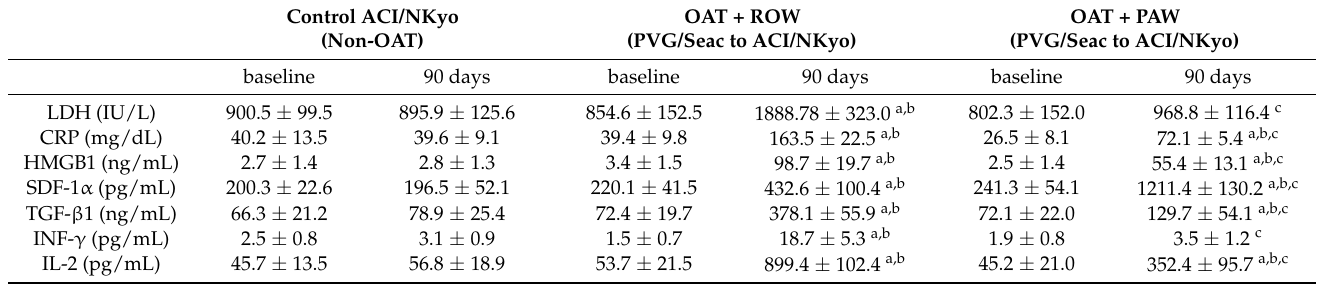
Table 2. Comparison of OAT-induced vasculopathy-related proteins in ACI//NKyo rats. Control ACI/NKyo (Non-OAT)